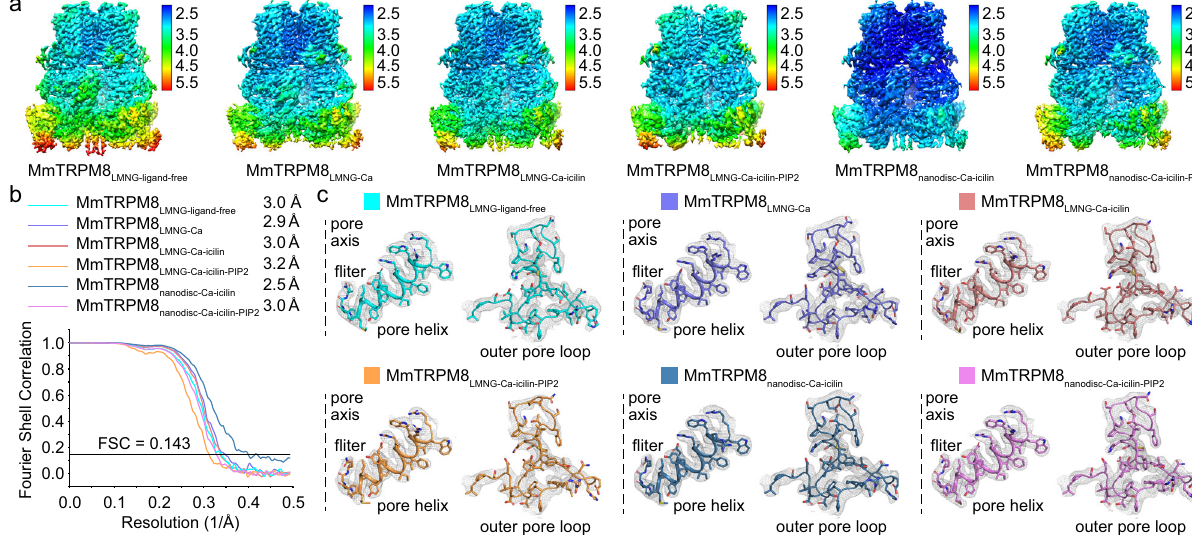
Fig. 1 Structure determinations of MmTRPM8. a The 3D reconstructions of MmTRPM8 colored by local resolutions in Å. b The Gold standard Fourier Shell Correlation (FSC) curves of the fi nal 3D reconstructions of MmTRPM8 in different ligand-bound states. Source data are provided as a Source Data fi le. c Local maps of MmTRPM8 structures in the regions of pore helix, selectivity fi lter, and outer pore loop at the contour level of 3.5 σ